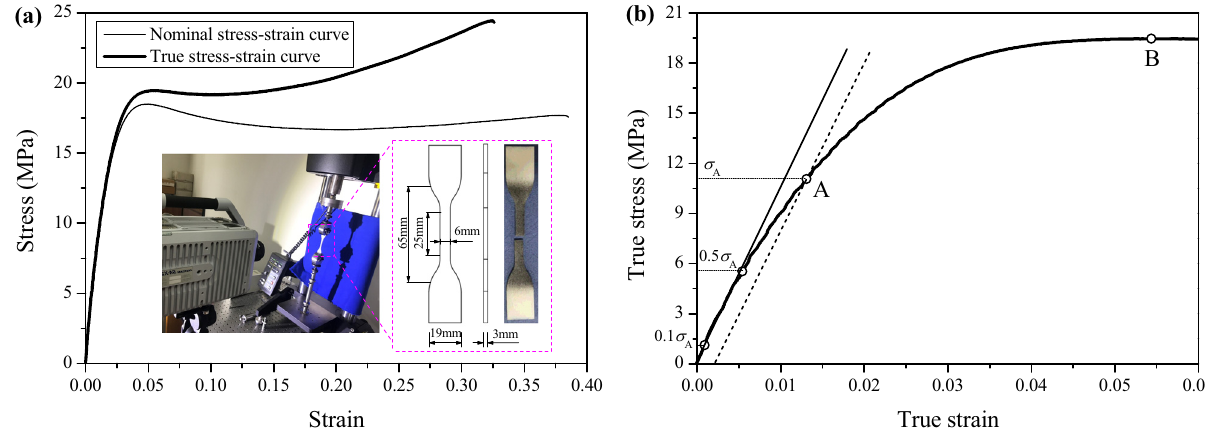
Figure 6: Nominal and true stress – strain curves of T8430 under quasi - static uniaxial tension ( a ) and schematic diagram of determining elastic modulus and yield strength ( b )